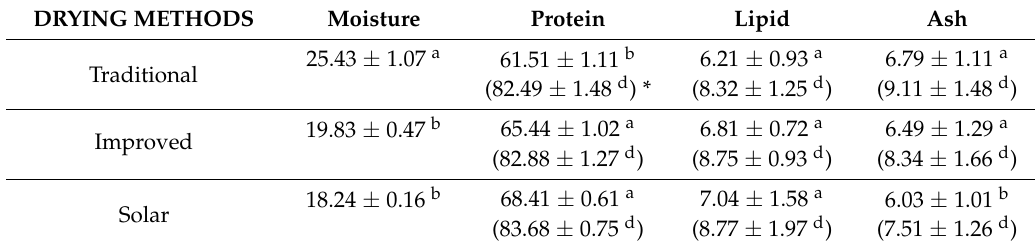
Table 1. Effect of drying methods on the proximate composition (%) of H. molitrix . Each value is expressed as a mean ± standard deviation (SD) ( n = 3). Means with different superscripts (a,b: fresh matter; d: dry matter) within a column are significantly different ( p < 0.05). * Figures in parenthesis indicate values on a dry matter basis.